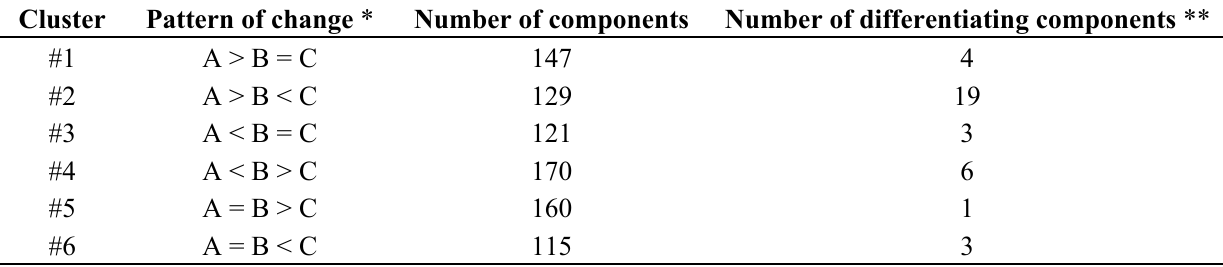
Table 2. Characteristics of identified clusters of spectral